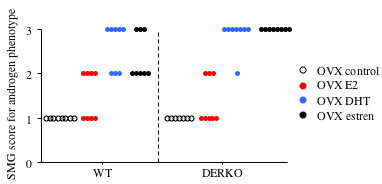
DHT and estren increase the androgen phenotype score in submandibular glands independently of estrogen receptors. Ovariectomized 11-months-old female WT and DERKO mice were given daily s.c. injections of E2 (0.7 μg/day), DHT (120 μg/day) or estren (75 μg/day) during four weeks. Control mice received olive oil. E2 treatment did not dramatically affect the androgen phenotype of SMG, in either WT or DERKO mice. THE SMG score for androgen phenotype was high for both DHT- and estren-treated mice, of both WT and DERKO genotype, when compared to control mice.